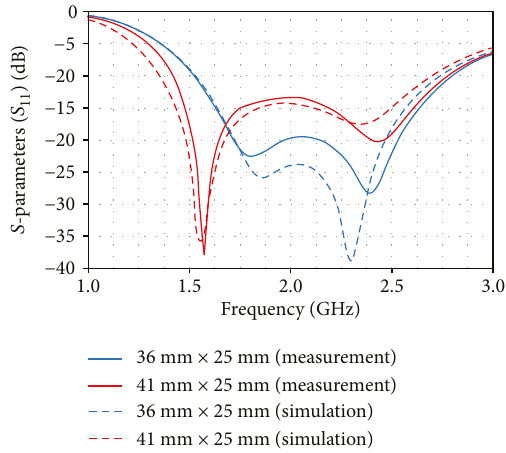
Figure 9: Simulated and measured S -parameters: S foldable PCB